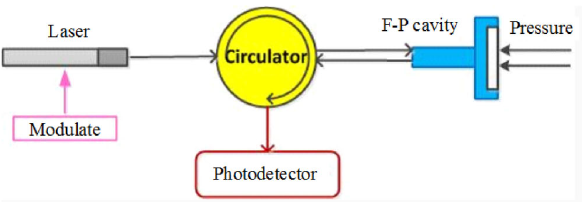
Fig. 1 PGC modulation and optical circuit